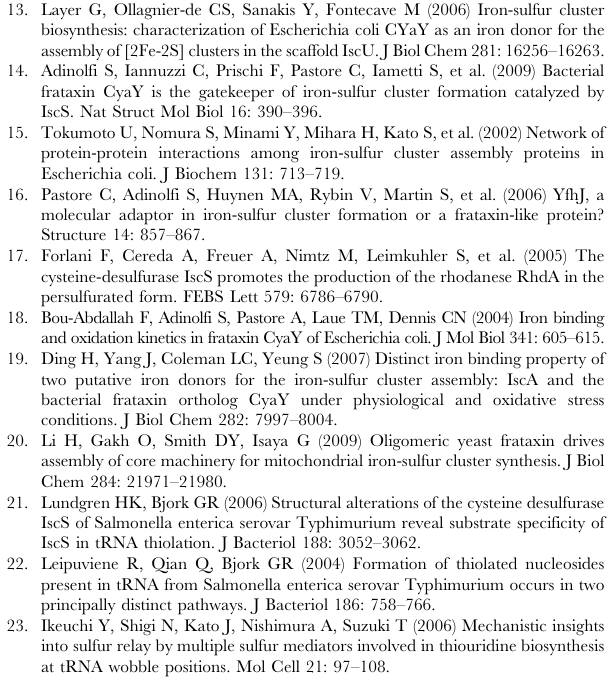
Figure S4 Superposition of Iscs-TusA and IscS-IscU showing the steric overlap of TusA and IscU. The IscS subunits are painted green and cyan, TusA is magenta, and IscU is wheat. The IscS Cys328 loop is colored red and the cysteines in all molecules are shown explicitly in stick mode. The steric clashes would occur in the circled region. The separation between positions of acceptor cysteines of TusA and IscU is in excess of 16 A˚ and is marked with an arrow. The distance between the cysteines of IscS and TusA is , 4 A˚ , while the distance between the cysteines of IscS and IscU is greater than 12 A˚ . Figure S5 Pull-downs of His-IscS by (A) IscU mutants and (B) TusA mutants. Figure S6 Three-way pull-downs. (A) Competition between TusA and IscU for IscS. Left: The preformed complex of His-IscS/ GST-TusA was loaded on Glutathione Sepaharose 4B column (lane 1) and washed thoroughly. Beads incubated with TEV protease and released His-IscS-TusA complex eluted (lane 2). GST-IscU (lane 3) loaded on Glutathione Sepaharose 4B column and washed (lane 4), His-IscS-TusA added and column washed. Incubation with TEV protease and elution of released proteins (lane 5). Only His-IscS and IscU were observed. Right: Similar experiment performed in opposite order. First the His-IscS-IscU complex was formed and was loaded on the column with bound GST-TusA. His-IscS-IscU did not bind to the column and only GST-TusA was found on the beads. (B) Competition between IscU and CyaY for IscS. The preformed complex of His-IscS/GST-IscU was loaded on Glutathione Sepharose 4B column and washed thoroughly (lane 1). Since both proteins run at the same place on the SDS-PAGE, the beads were incubated with TEV protease and released proteins were eluted from the column (lane 2) confirming the presence of His-IscS-IscU complex. GST-CyaY was loaded on Glutathione Sepharose 4B column (lane 3) and His-IscS-IscU added to the column and washed (lane 4). Finally, incubation with TEV protease released His-IscS,